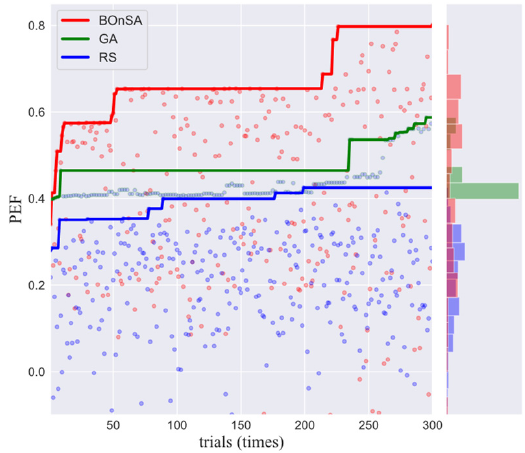
Figure 6. The optimization trajectories using three different algorithms with their historical PEF distribution histograms.